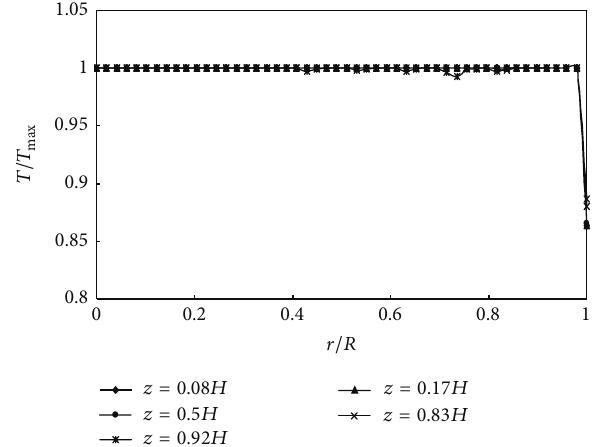
Figure 10: Profile of radial dimensionless